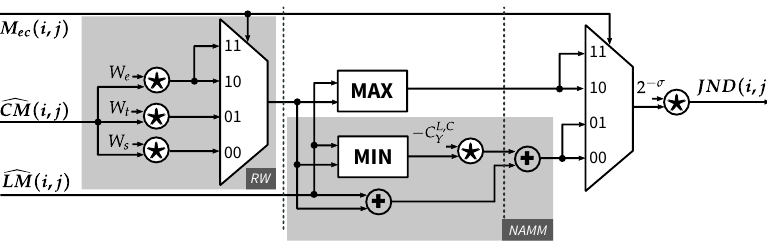
Figure 15. JND calculation